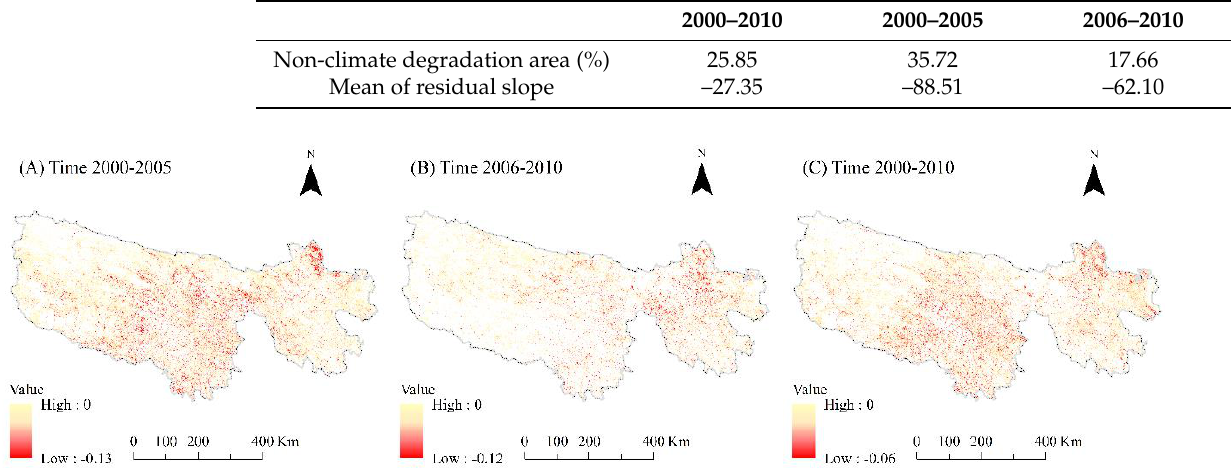
Table 4. Proportion of area showing non-climate degradation (units %) and the trend of the residual mean value.